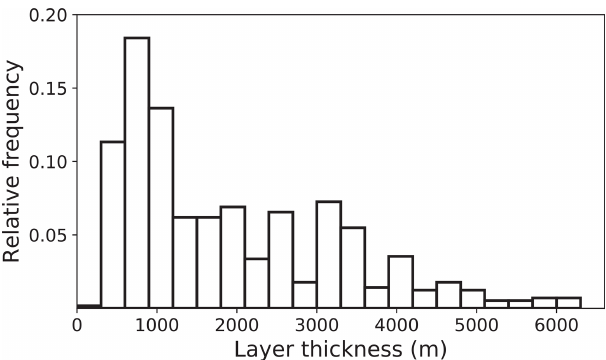
Figure 6. Ice-nucleating particle (INP) concentration estimated from the smoke extinction coefficients in Fig. 4c, assuming hetero- geneous ice nucleation (deposition nucleation) on soot particles at the temperature T = − 55 ◦ C and a typical ice supersaturation level during cirrus formation of S ice = 1 . 15 (Ullrich et al.,